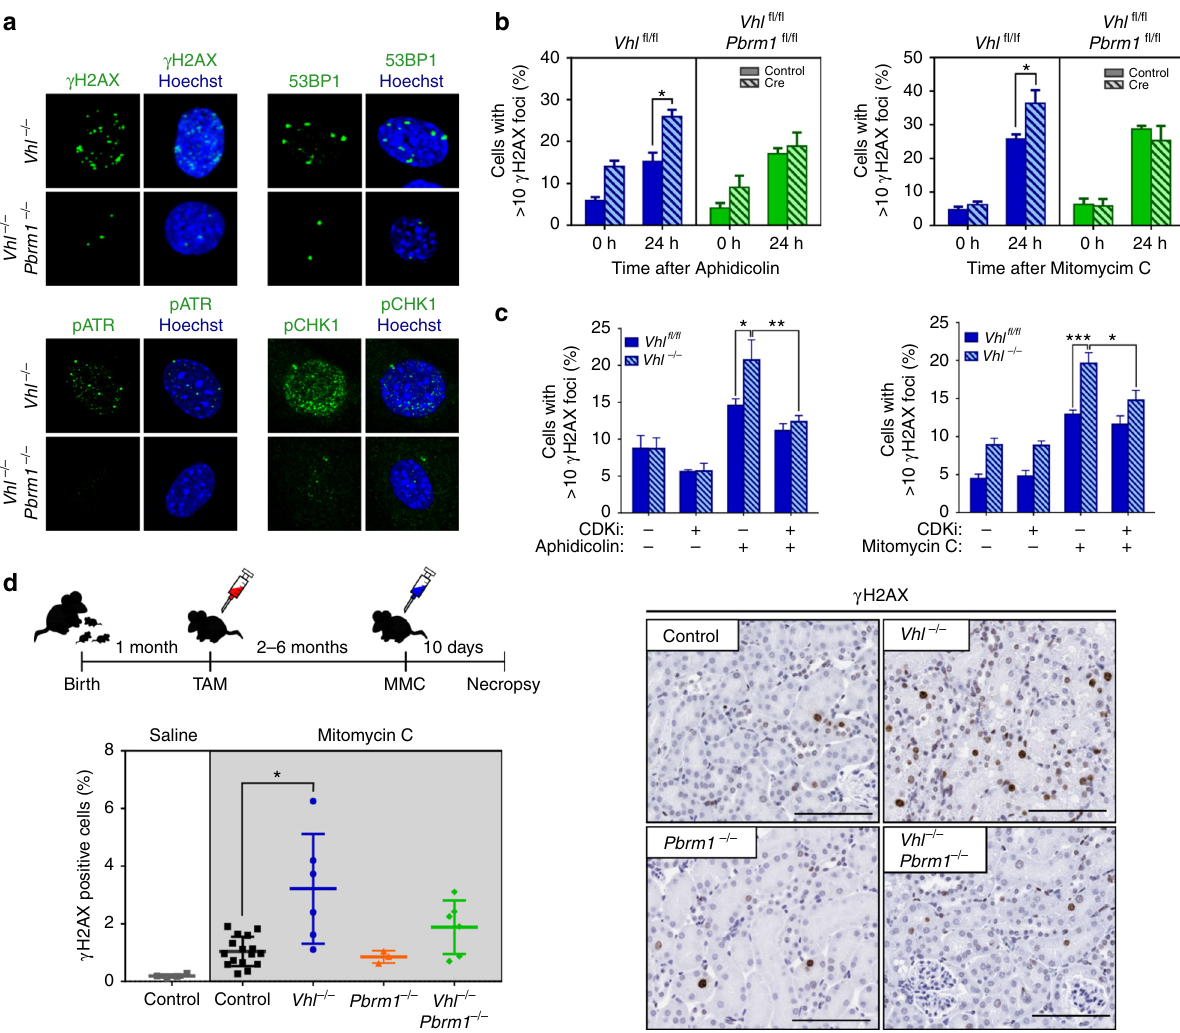
Fig. 1 Loss of VHL induces replication stress rescued by concomitant loss of PBRM1. a Representative photos of immuno fl uorescence staining in day 20 recombined MEFs. b , c Quanti fi cation of γ H2AX foci formation following treatment of MEFs as indicated ( b , n (independent experiments) = 3; c , left, n (independent experiments) = 6; right, n (independent experiments) = 4). d Schematic of experimental design of in vivo Mitomycin C (MMC) experiment; renal γ H2AX quanti fi cation following MMC and representative immunohistochemical photos ( n (mice); Saline: control = 6; MMC: control = 16; Vhl − / − = 6; Pbrm1 − / − = 3; Vhl − / − ;Pbrm1 − / − = 7). TAM: tamoxifen. Scale bars, 100 μ m. b , c Graphs depict means ± s.e.m. (error bars); two-way ANOVA, Sidak ’ s correction. d , Graph depicts means ± s.d. (error bars); Kruskall – Wallis, Dunn ’ s correction. *** p < 0.001, ** p < 0.01, * p